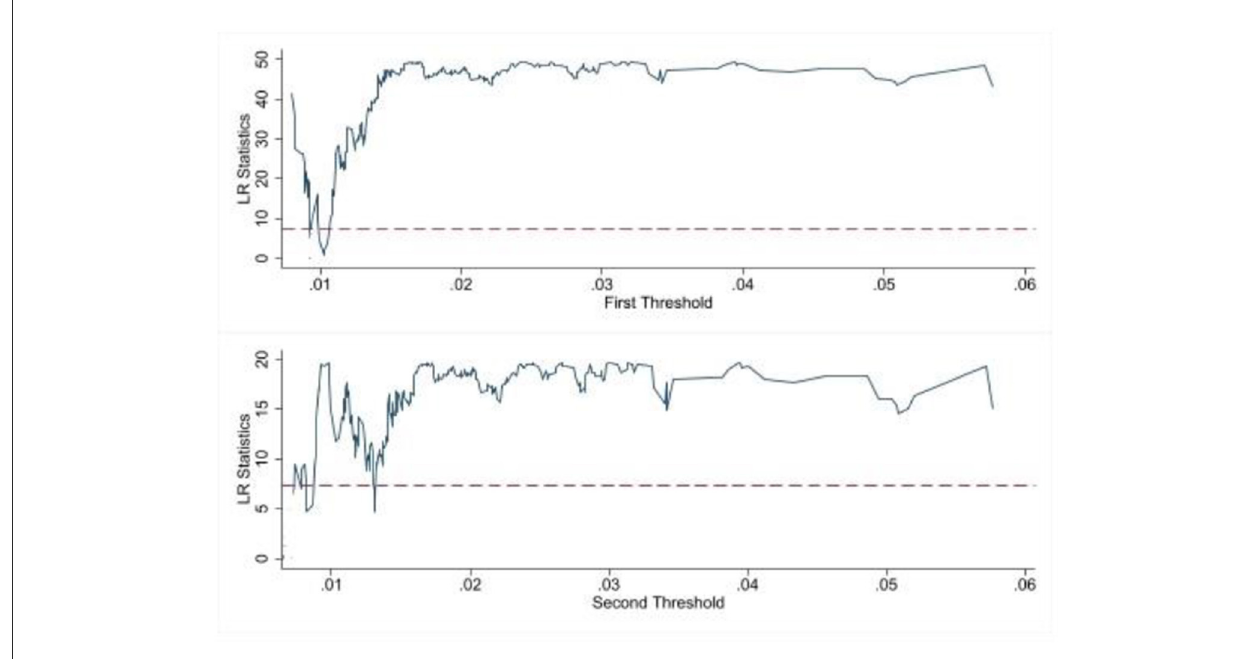
FIGURE4 LR statistics chart on